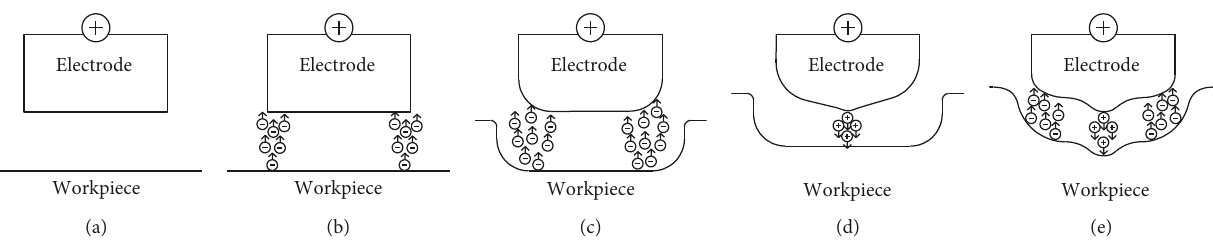
Figure 5: Graphic of the changing process of the electrode bottom (negative polarity machining).